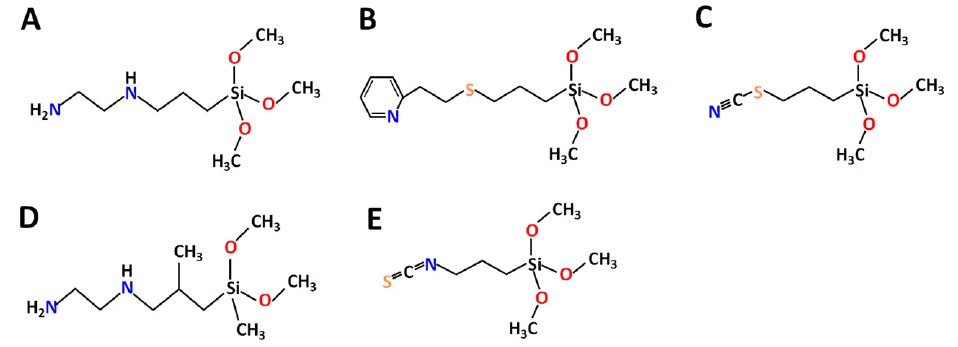
Figure 1. Chemical structure of selected ligands: ( A ) L1 , ( B ) L2 , ( C ) L3 , ( D ) L4 and ( E ) L5. Previously, N-(2-Aminoethyl)-3-aminopropyltrimethoxysilane has been used in modi- fication of silicone tie-paints as a curing component, resulting in significantly improved ad- hesion between the tie-coating and the epoxy primer [35]. In another work by Zhang et al. [36], L1 was used for lacquer surface modifications, which showed considerably enhanced aging and corrosion resistance properties. To the best of our knowledge, none of these ligands ( L1–5 ) have previously been tested for metal uptake and selective adsorption. The func- tionalized nanoparticles were characterized extensively and their behavior in solution was investigated both for the adsorption and separation of REEs and LTM by selective